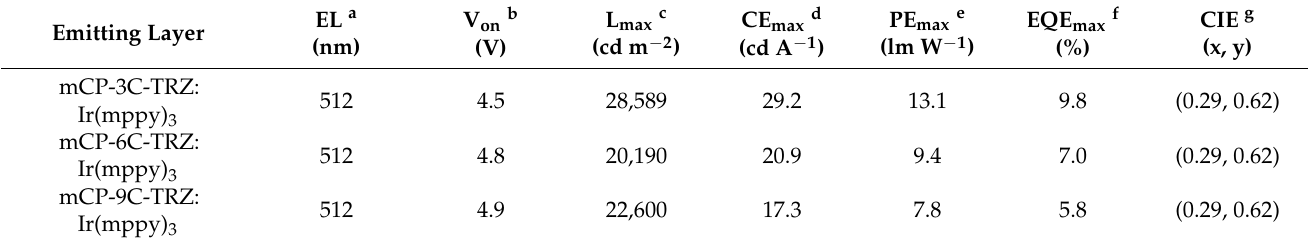
Figure 7. ( a ) Energy diagram of the materials used in the devices, ( b ) chemical structures of organic materials in OLEDs, ( c ) normalized EL spectra in the doped devices, ( d ) current density – voltage – luminance (J – V – L) curves, ( e ) external quantum efficiency versus luminance curves. Table 2. Device performances of the solution-processed phosphorescent